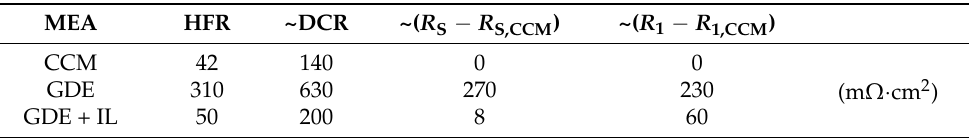
Table 1. Cell HFR, estimated DC resistance (~DCR) and derived estimates of contact resistances, relative to that of the CCM-based MEA, for the different fabrication methods (see text for further explanation). Note the cell HFR values do not match the ex situ impedance measurements (Figure 3) quantitatively because the fuel cell operates with membrane and CLs in hydroxide form, while the MTS measurements were performed in HCO 3 −